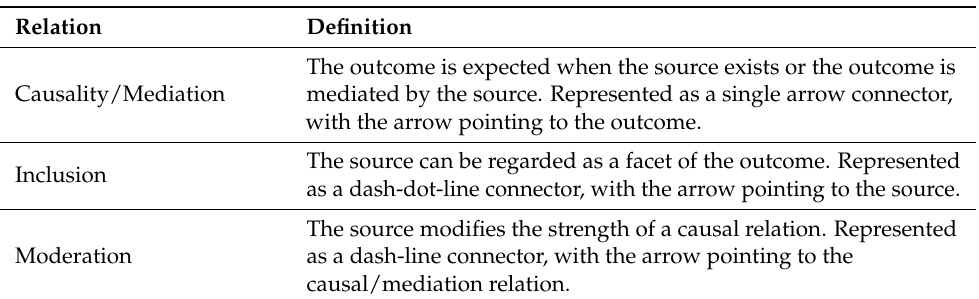
Table 5. Definitions of relation types.